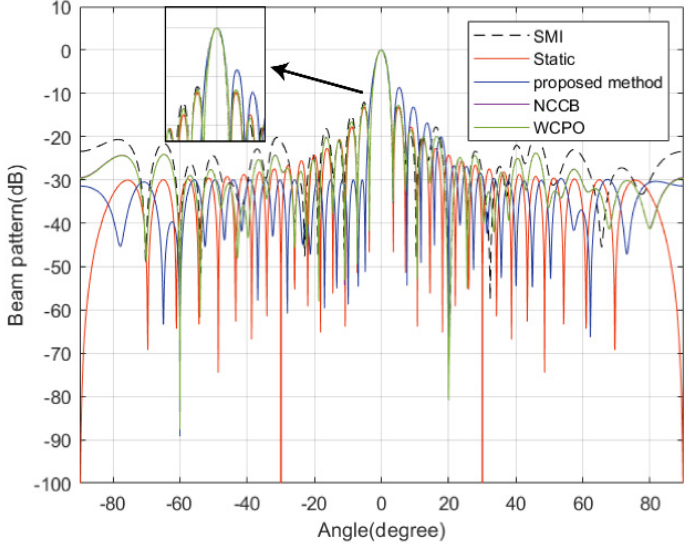
Figure 2. Beampatterns synthesized by different beamformers.